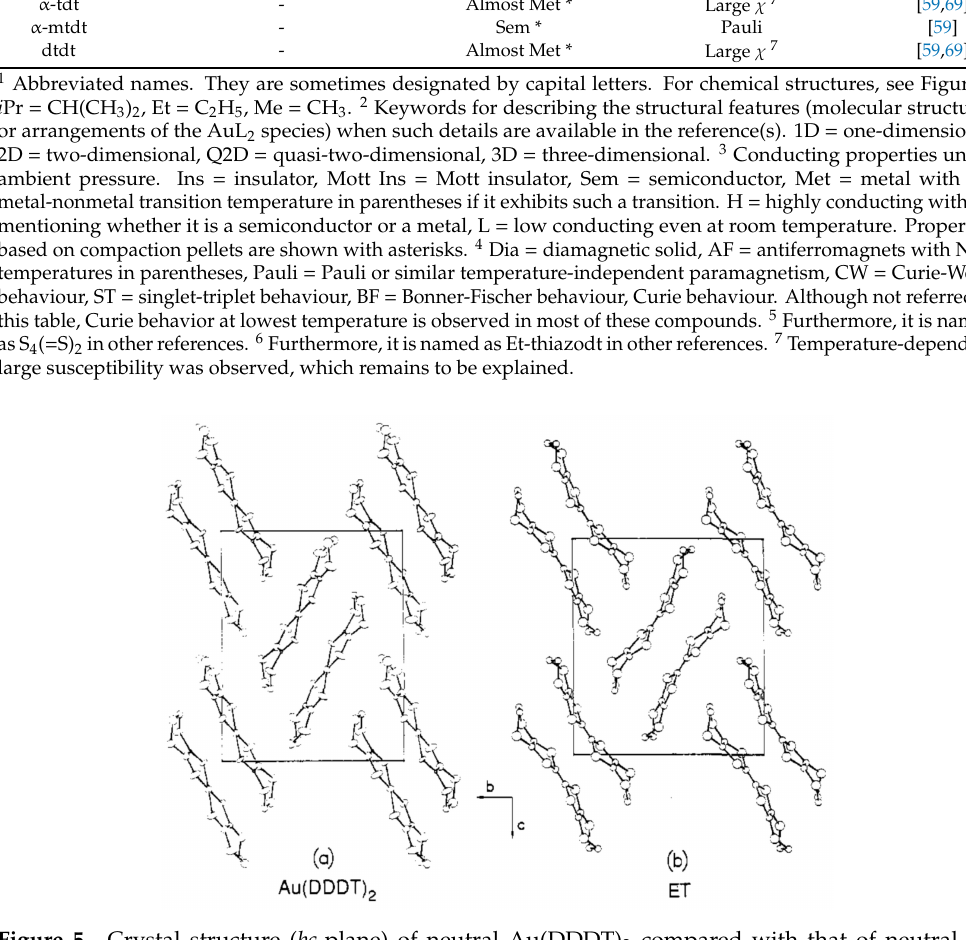
Figure 5. Crystal structure ( bc -plane) of neutral Au(DDDT) 2 compared with that of neutral ET: ( a ) Au(DDDT) 2 ; ( b ) ET (reported originally in Ref. [70]). Reproduced from Ref. [43] with